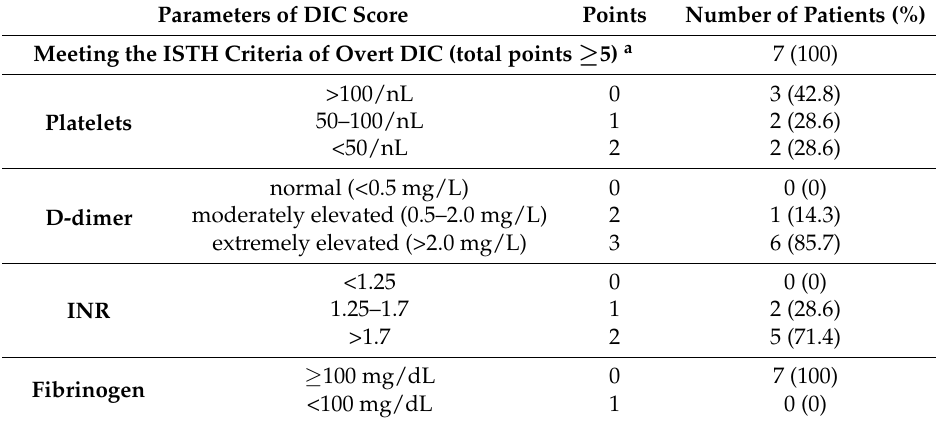
Table 3. Constituting subscores of the DIC score in the seven patients with overt DIC. Parameters of DIC